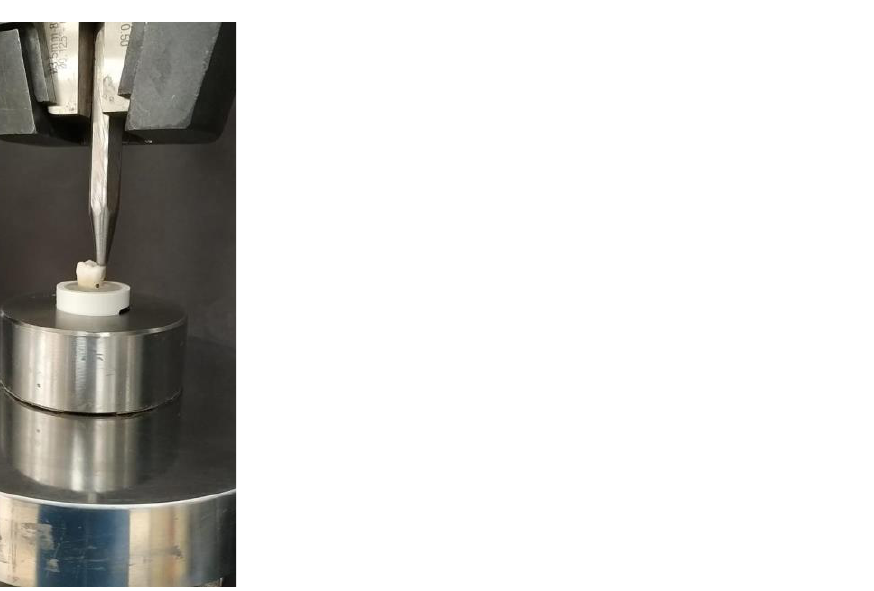
Figure 1. Graphical illustration of the study design.